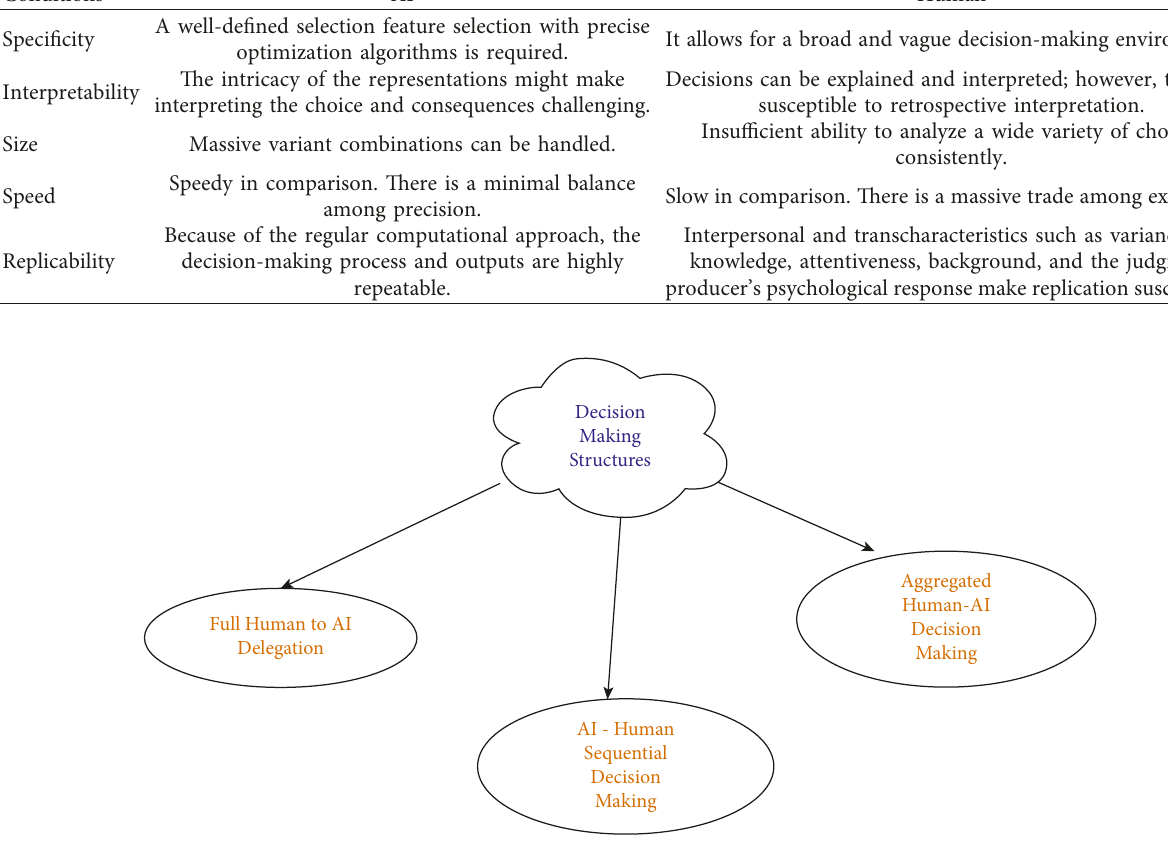
Figure 6: Structures related to